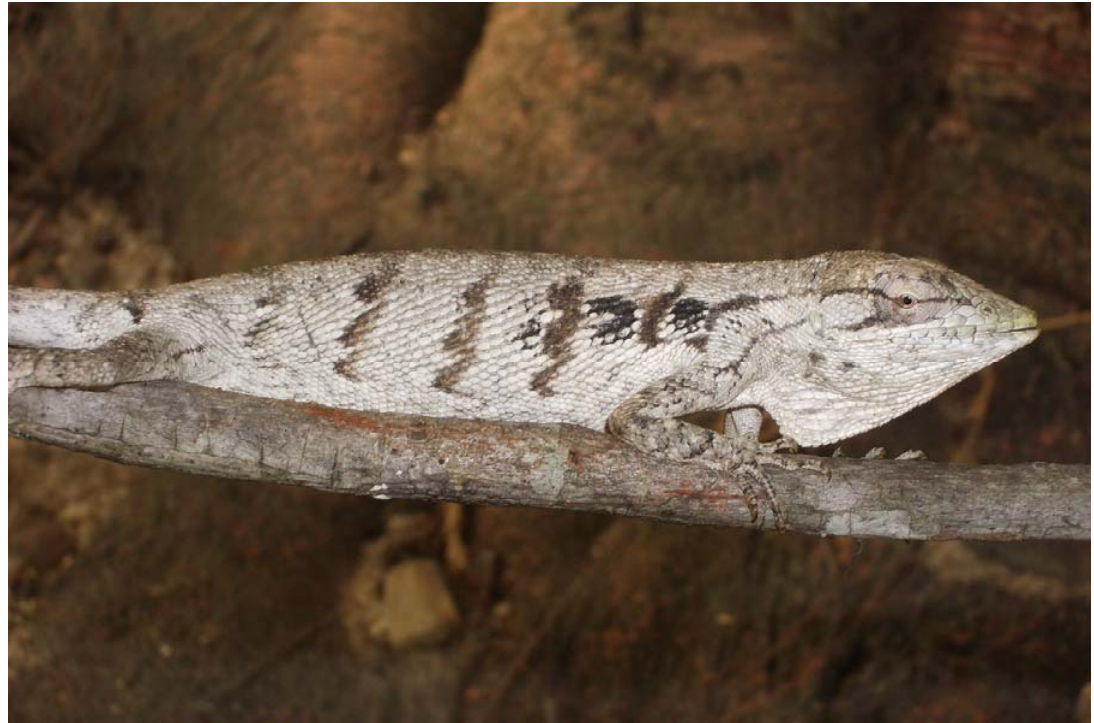
Figure 4 . Adult male P. acutirostris collected at the municipality of Chapada dos Guimarães. Photo by C.